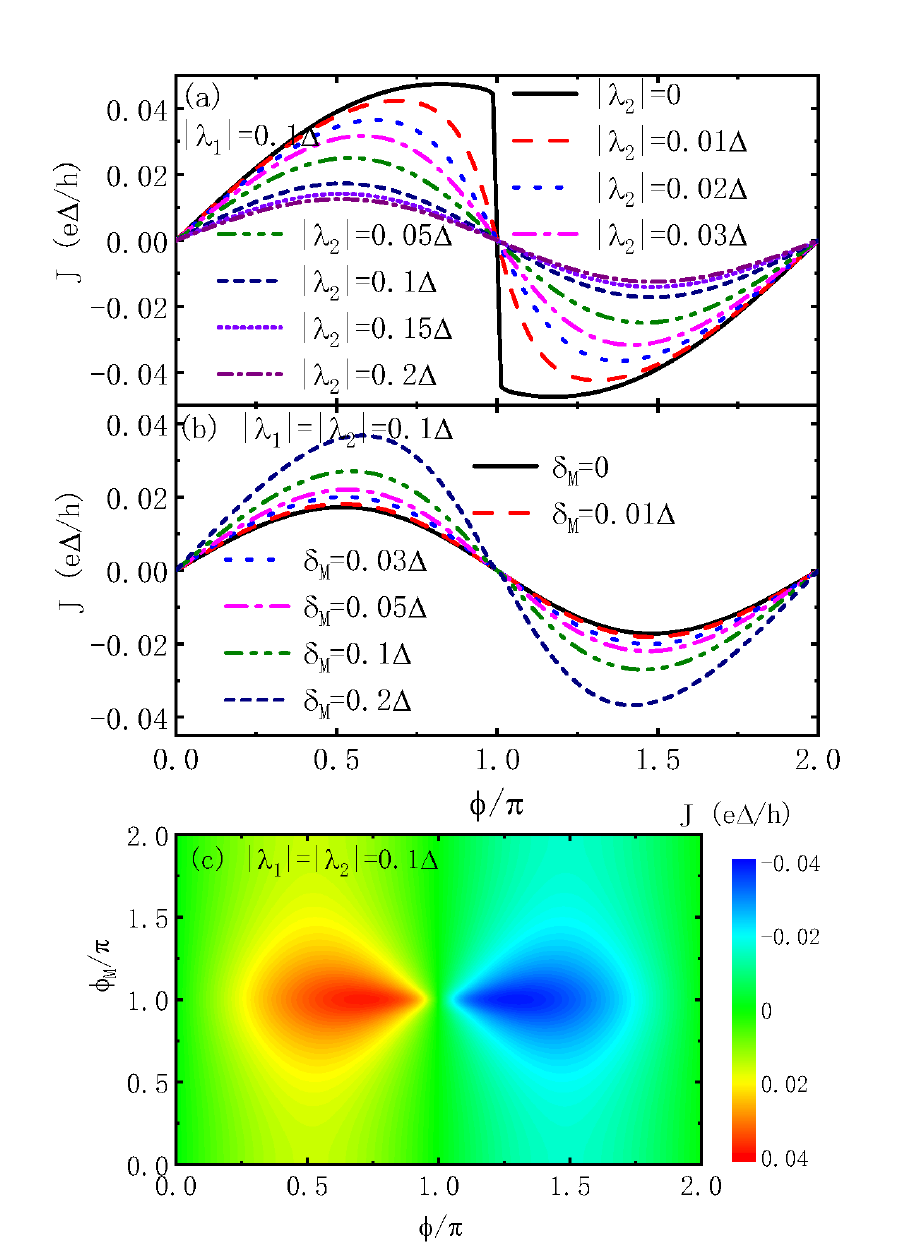
Figure 4. (color online) Josephson current as a function of φ for different | λ 2 | in ( a ) and δ M in ( b ). ( c ) The counter plot of the Josephson current as a function of φ M and φ . Other parameters are as in Figure